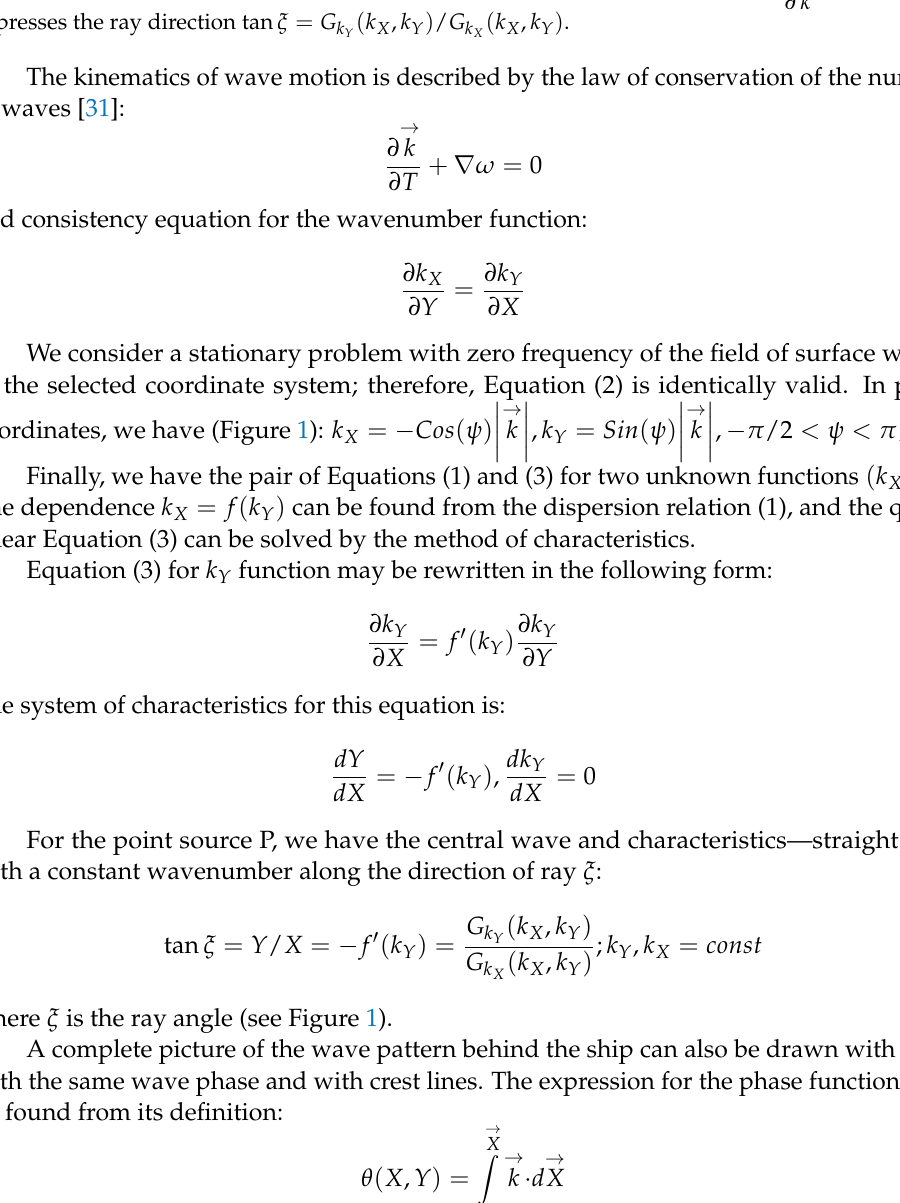
Figure 2. The geometry of waves behind the ship. U is the flow velocity, k —wave number vector of surface waves, ( ξ , ψ )—ray and wave number vector angles, respectively; vector expresses the ray direction tan ξ = G k G Y X k X Y k X Y